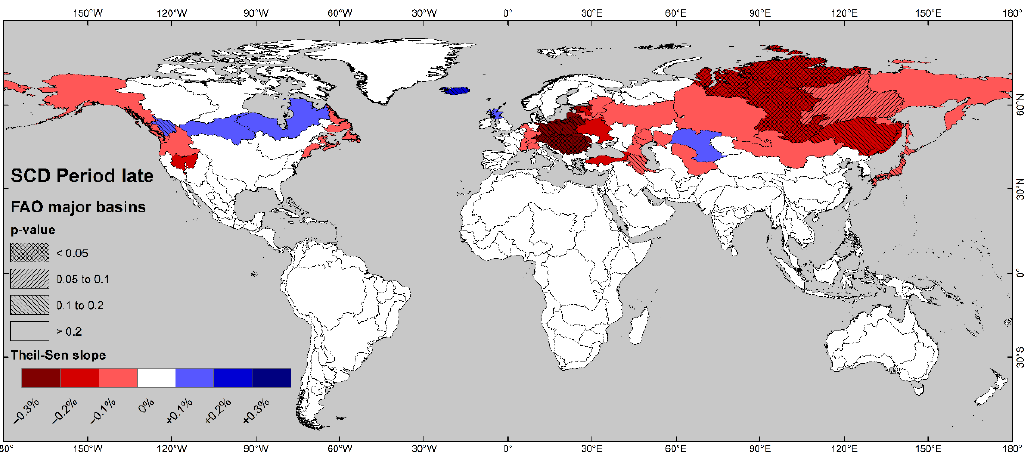
Figure 15. Basin-based development of the late season SCD . The Theil–Sen slope is color coded and the corresponding p -values are hatched over it.